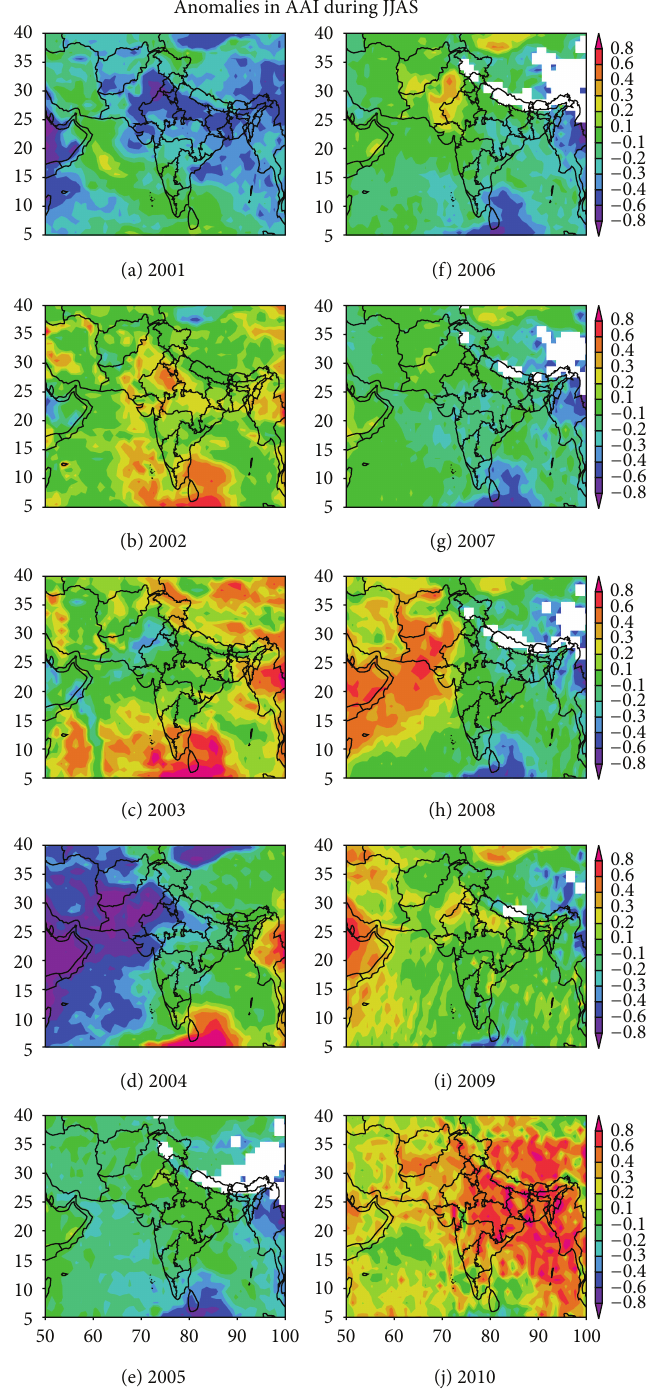
Figure 8: Anomalies in absorbing aerosol index (AAI) during the southwest monsoon season (JJAS) in (a) 2001, (b) 2002, (c) 2003, (d) 2004, (e) 2005, (f) 2006, (g) 2007, (h) 2008, (i) 2009, and (j) 2010 over the Arabian Sea, India, and the Bay of